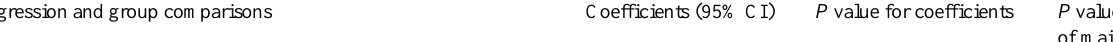
P value for coefficientsCoefficients (95% CI)Regression and group comparisons